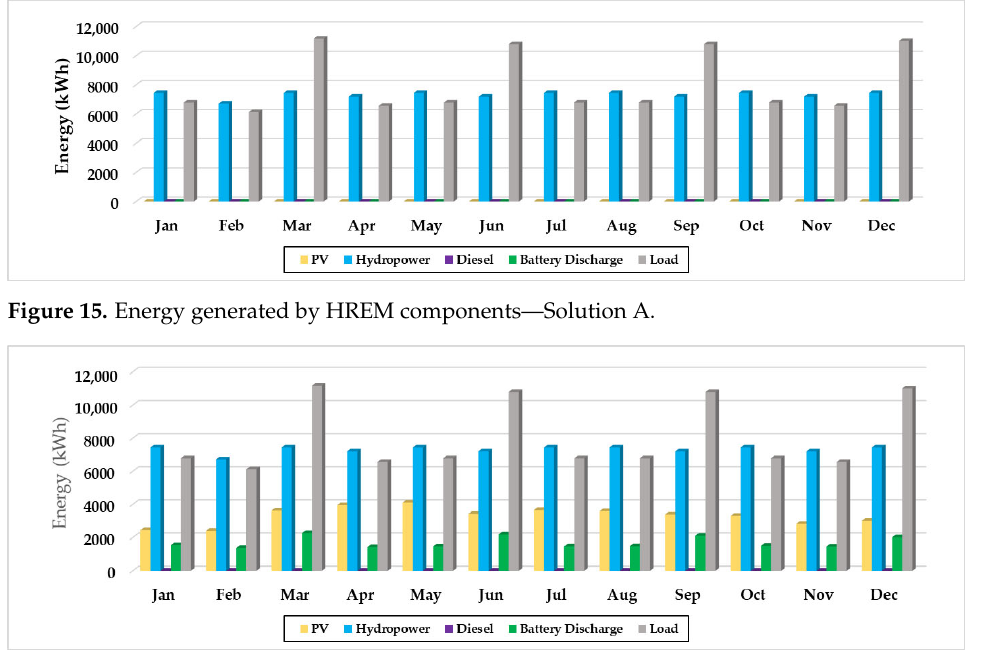
Figure 16. Energy generated by HREM components—Solution